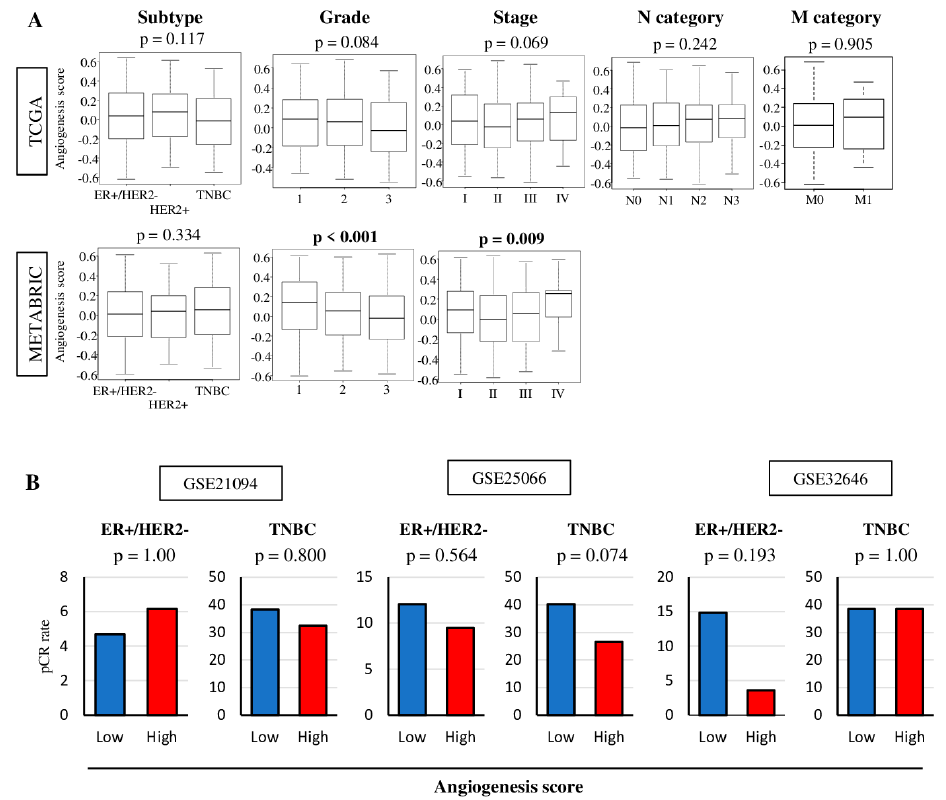
Figure 2. Association between clinical features and the tumor angiogenesis score in TCGA and METABRIC breast cancer cohorts. The median was used as a cut-off to divide patients into high and low score groups within each cohort. ( A ) Boxplots of the angiogenesis score by breast cancer subtype, Nottingham pathological grade, and American Joint Committee on Cancer (AJCC) cancer stage in the TCGA and METABRIC cohort, and AJCC N and M category in TCGA cohort. One-way ANOVA test was used to calculate p values. Tukey type boxplots show median and inter-quartile level values. ( B ) Pathological complete response (pCR) rate for neoadjuvant chemotherapy between low (blue) and high (red) angiogenesis pathway score in estrogen receptor-positive/human epidermal growth factor receptor 2-negative (ER+/HER2-) and triple negative breast cancer (TNBC) in the GSE20194 ( n = 197), GSE25066 ( n = 467), and GSE32646 ( n = 81) cohorts. Two tailed fisher’s exact test was used to calculate p values.